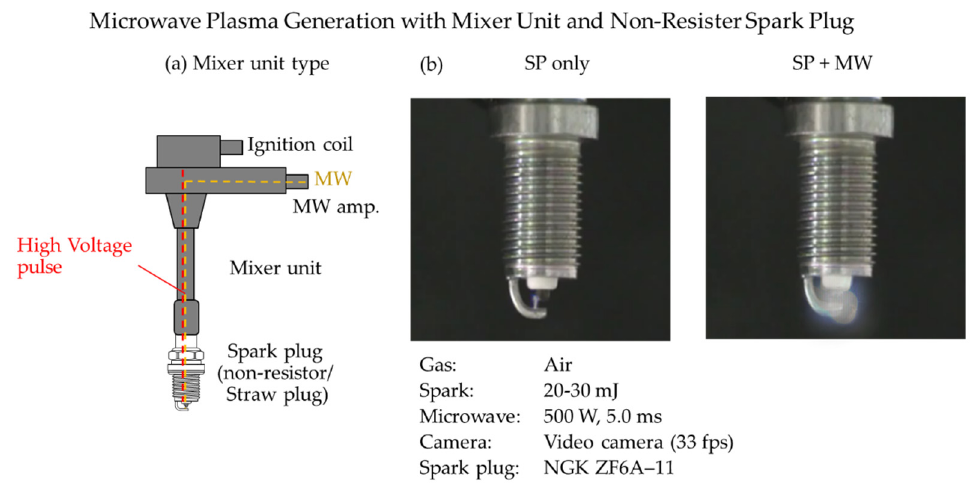
Figure 10. ( a ) Schematic diagram of microwave-assisted spark plug. ( b ) Actual images of plasma generated by spark plug with and without microwave input.